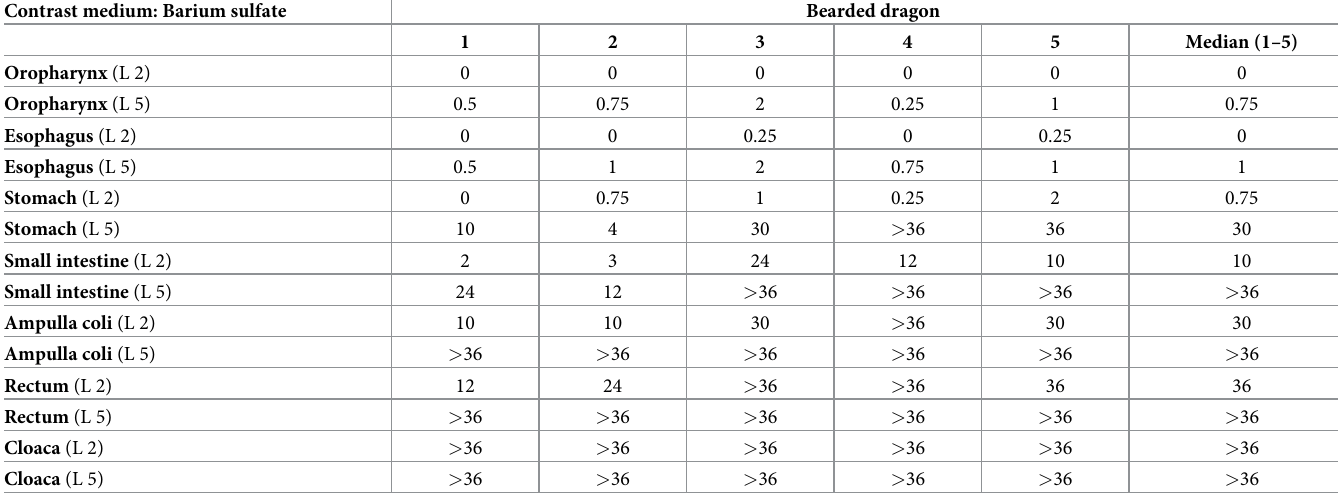
Table 4. Time (in hours) at which barium sulfate completely filled (L2, top row) and had completely left (L5, bottom row) each segment of the gastrointestinal tract (for each single tested animal). Contrast medium: Barium sulfate